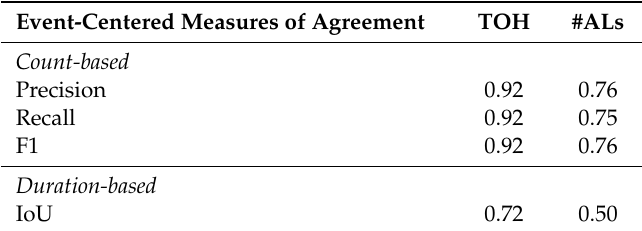
Table 7. Measures of agreement on the level of